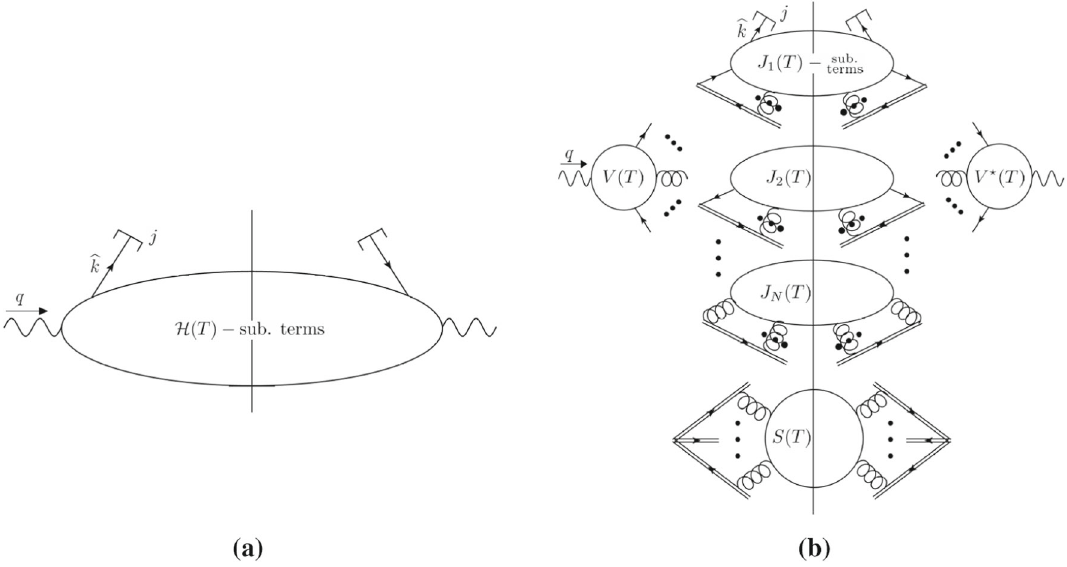
μν μν . b Factorization of (cid:6) W , in which soft and collinear contributions are explicitly represented, according j j